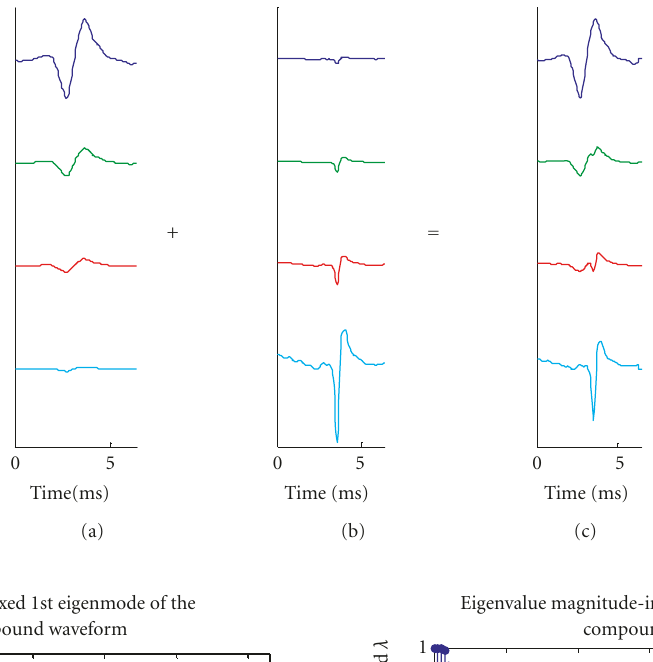
j j (cid:6)= 0. It is clear that the error reaches a minimum in nodes 1 , j 1 in descending order of magnitude. This allows identifying a threshold j ∗ − u 0 (cid:13) 1 1